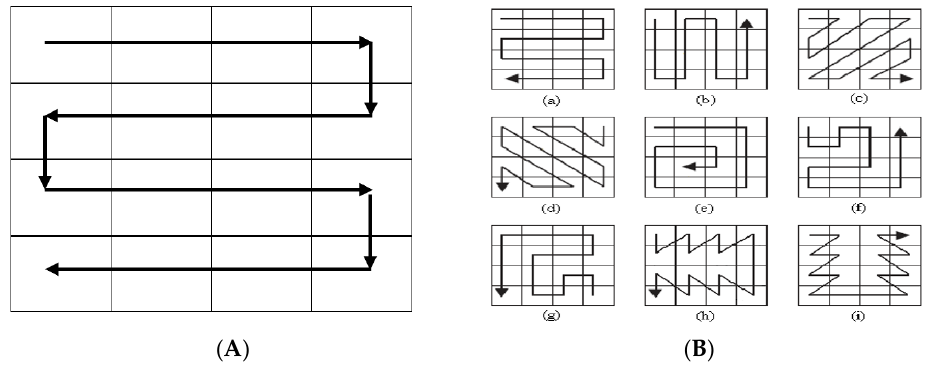
Figure 4. Scanning and its types, ( A ) Inverse S scanning, ( B ) Different types of scans .